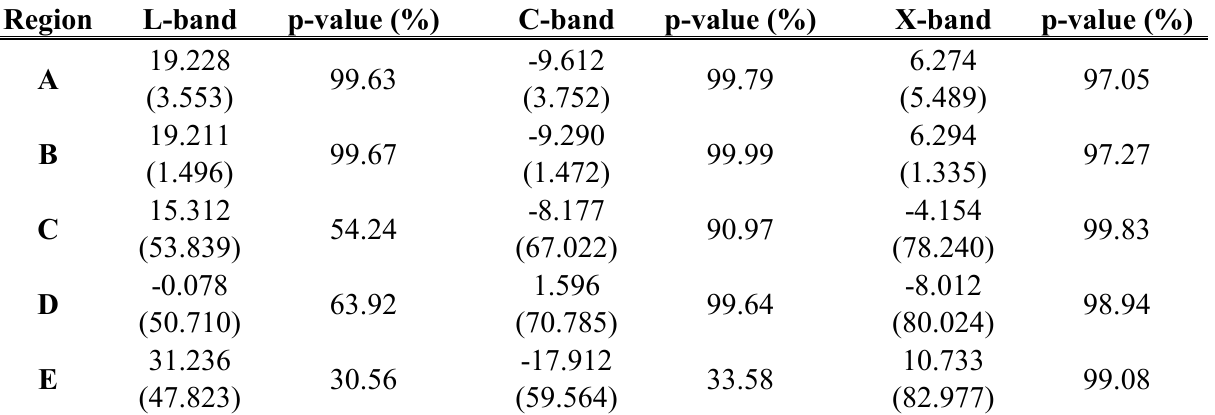
Table 5. PPD mean and standard deviation and p-value for the goodness-of-fit